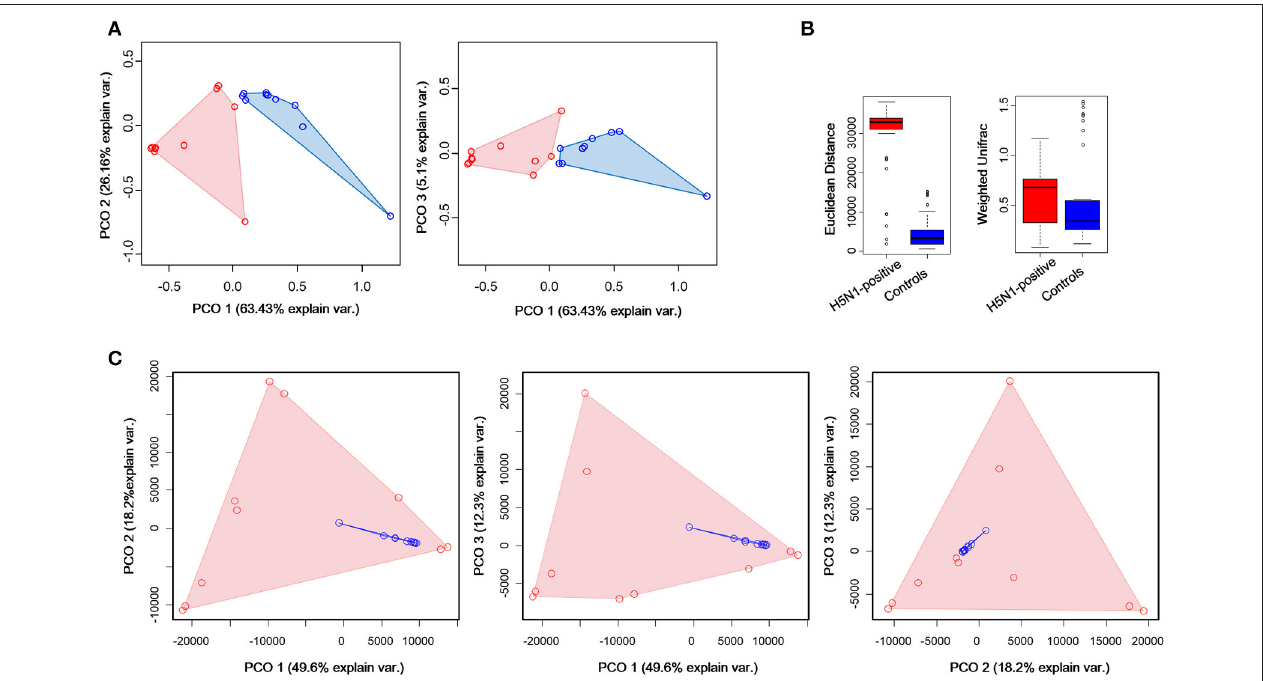
FIGURE 4 | Greater compositional heterogeneity among H5N1-infected gut microbiomes than among uninfected controls. (A) The difference in the composition of the gut microbiota is illustrated by principal-coordinate plots of the weighted unifrac matrix among samples. All pairwise comparisons involved the first, second and third principal axes. The first, second and third principal axes explained most of the variance (63.43, 26.16, and 5.1%, respectively). Dots and surrounding areas correspond to gut bacteria communities from healthy controls (blue) and H5N1-infected individuals (red). (B) The relative abundance of bacterial phylotypes between the H5N1-infected samples (red bars) and the healthy control samples (blue bars). Asterisks indicate statistically significant differences ( p < 0.01), and the error bars denote 95% confidence intervals for the mean values. (C) The difference in the composition of the gut microbiota is illustrated by principal-coordinate plots of the Euclidean distances among samples. All pairwise comparisons involved the first, second and third principal axes. The first, second and third principal axes explained most of the variance (58.3, 26.3, and 12.6%, respectively). Dots and surrounding areas correspond to gut bacteria communities from healthy controls (blue) and H5N1-infected individuals (red).